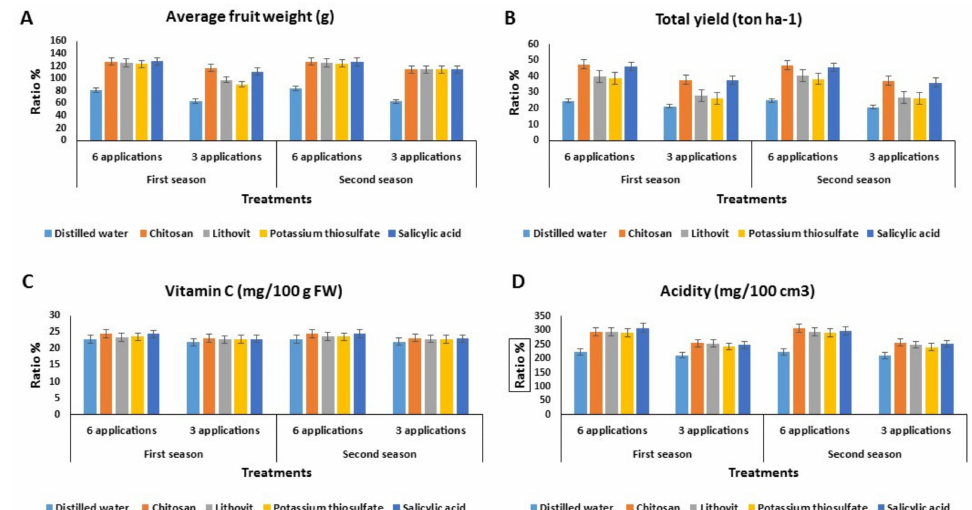
Figure 2. The e ff ect of the four tested chemicals as pre-harvest foliar application on yield and quality of tomato fruits during two growing seasons 2017 and 2018. ( A ) Average fruit weight (g), ( B ) total yield (ton ha − 1 ), ( C ) vitamin C (mg / 100 g FW), and ( D ) acidity (mg / 100 cm 3